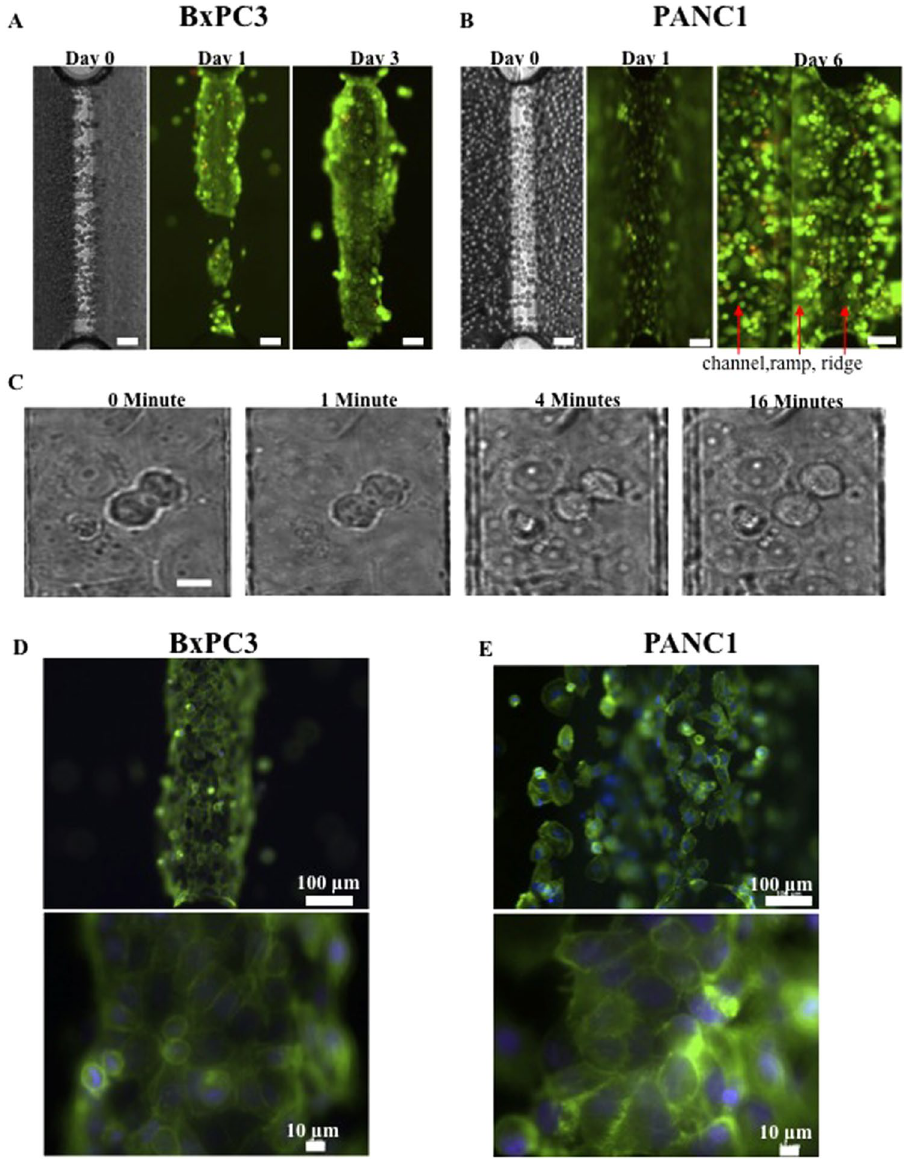
Figure 4. In vitro cell growth characteristics of PDAC cells in the HepaChip ® . (A) Live/Dead cell staining of BxPC3: BxPC3 grow selectively on the ridge. (B) Live/Dead cell staining of PANC1: In contrast the PANC1 spread as well channel walls and bottom, so the picture on day 6 was taken in two focal planes: on the channel and on the ridge. (C) Mitosis of BxPC3: Mitosis was observed inside the chip on the collagen coated area after 16 h culture. From left to right pictures taken after 0 min – 1 min – 4 min – 16 min using an inverted microscope. (D) Cytoskeleton assembly of BxPC3 and (E) of PANC1: Fluorescence images after actin and nucleus staining with Phalloidin and DAPI. Scale bars in A and B represent 100 µ m, in C represents 10 µ